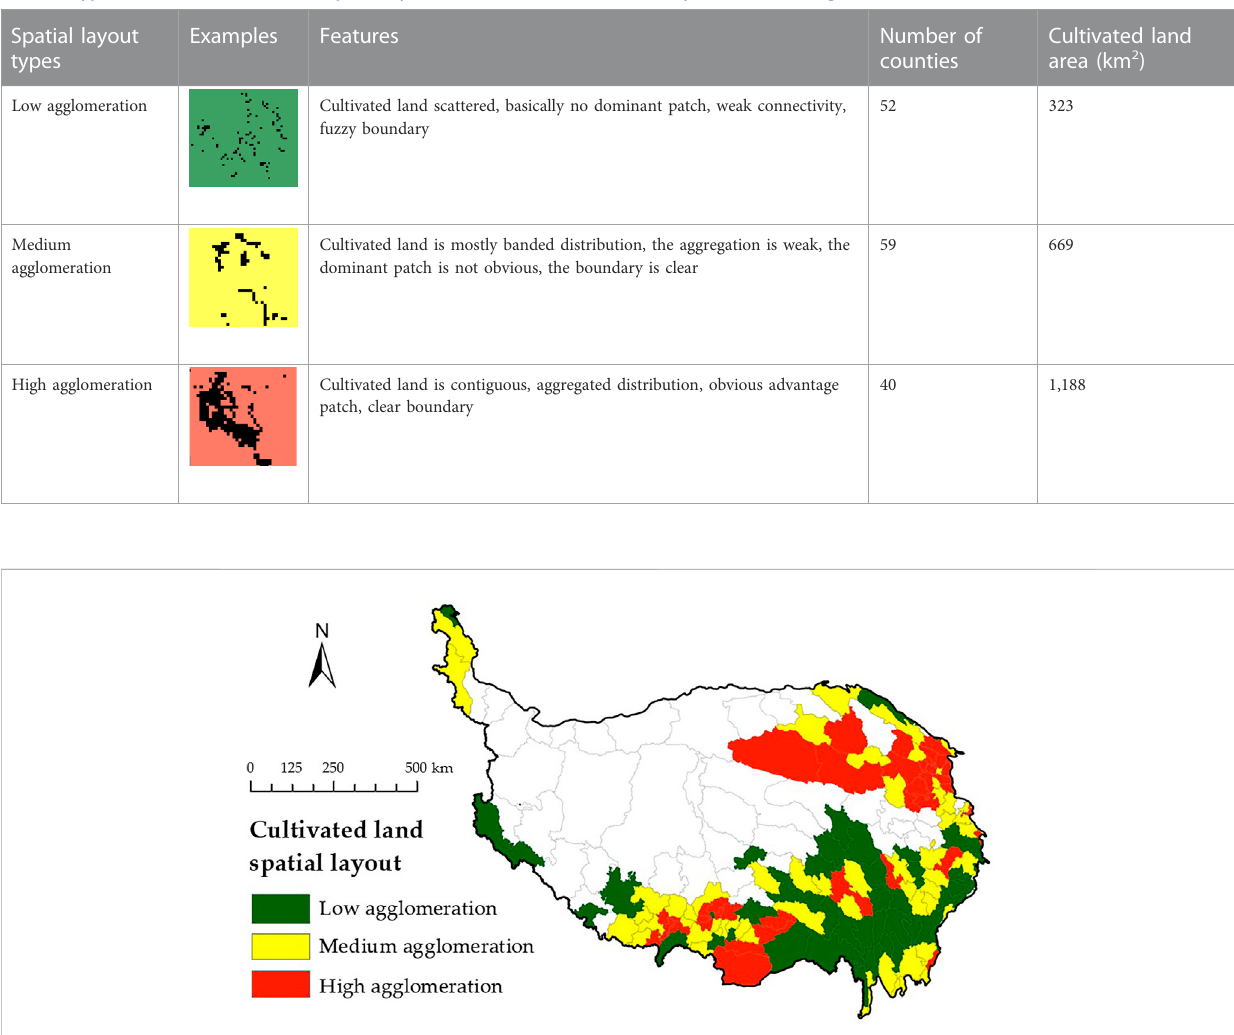
mainly distributed in the Hung River valley of Qinghai, Sichuan, and